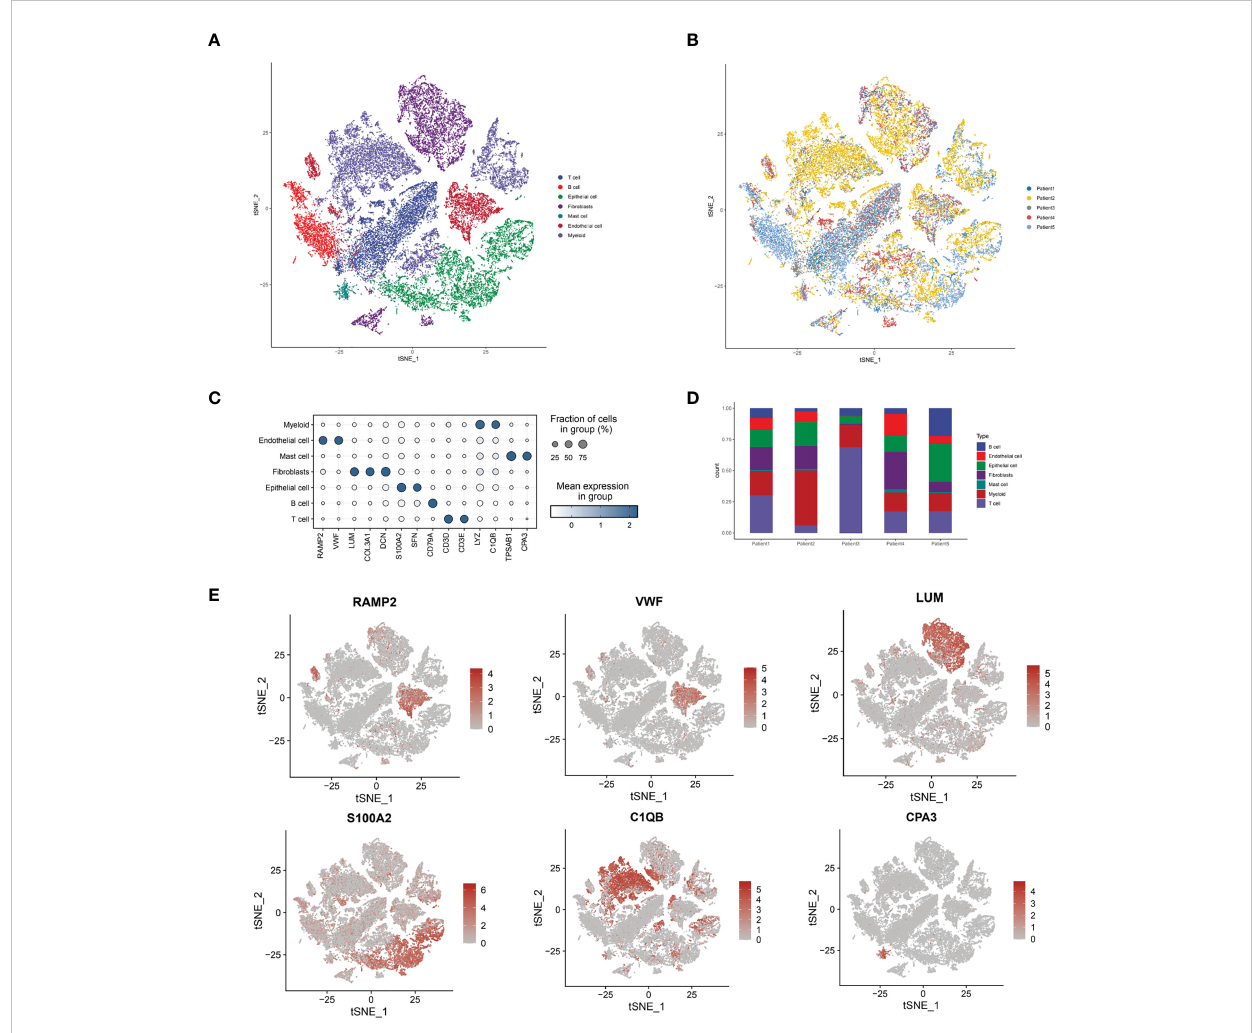
FIGURE 1 Sample immune cell type analysis and lysosomal pathway gene distribution by single cell sequencing of ESCC cells. (A) t-SNE diagram showing the distribution of 7 major cell types in ESCC cells: Tcell.B cell,Epithelial cell, Fibroblasts, Mast cell, Endothelial cell and Myeloid; (B) t-SNE diagram showing the source of the cell samples, each colour indicates one sample, a total of 5 patients are included; (C) bubble diagram of the major genes and groups expressed in the 7 cell types obtained from single cell sequencing, the results show that in Myeloid cells, LYZ and C1QB genes are highly expressed; in Endothelial cells, RAMP2 and VWF have high expression. LYZ and C1QB genes are highly expressed; in Endothelial cells, RAMP2 and VWF possess high expression; (D) Cascade bar graphs further visualize the speci fi c type number share of the 7 immune cell types in ESCC patients, with Myeloid cells, T cells, Fibroblasts more annotated and other cell types less abundant; (E) t SNE plots show the expression of typical marker genes for the different cell